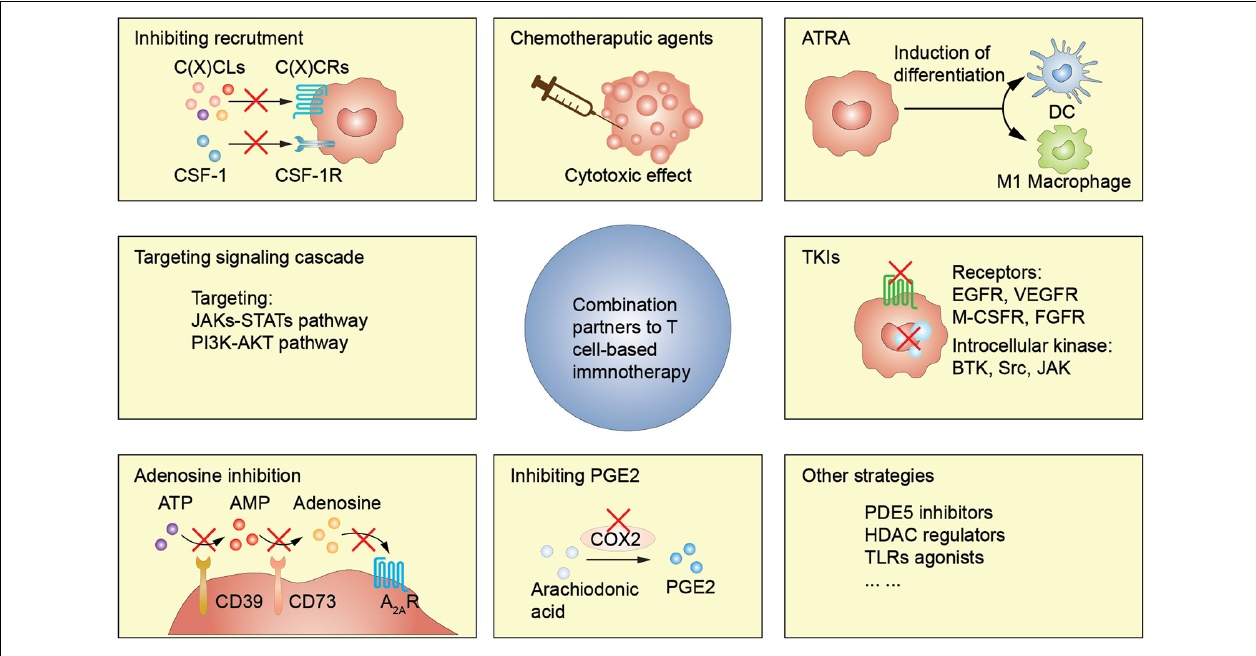
FIGURE 2 | MDSCs-targeting strategies enhance T cell-based immunotherapy efficacy. ATRA, all-trans-retinoic acid; TKI, tyrosine kinase inhibitor; PDE5, phosphodiesterase-5; HDAC, histone deacetylase; TLRs, toll-like receptors.